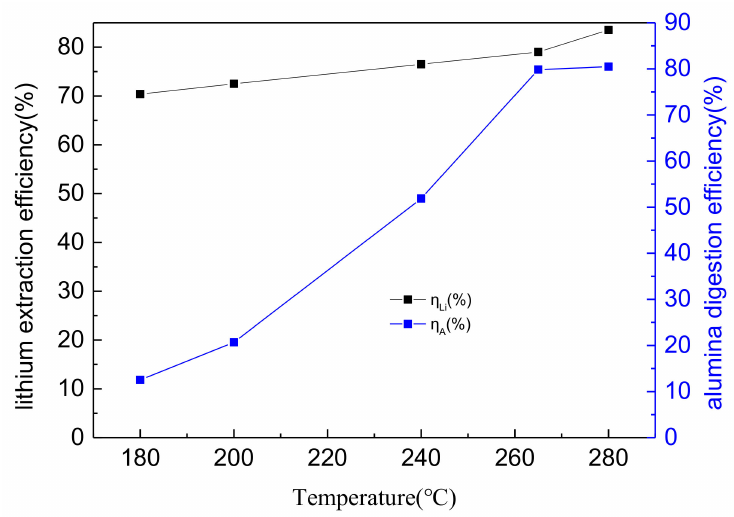
Figure 6. Effect of digestion temperature on lithium and alumina digestion behavior of bauxite (conditions: ρ (K 2 O) = 254 g/L, mass ratio of CaO/ore = 8%, t = 1